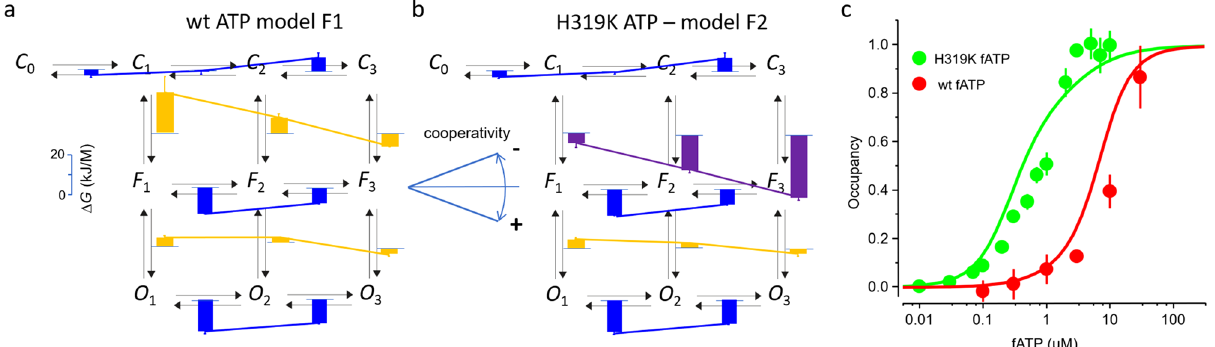
Figure 6. Gibbs free energies and predicted binding. ( a ) Gibbs free energy in model F1 and F2 for the association in the binding steps, Δ G A , at the ligand concentration L = 1 μM close to the EC 50 value of 1.2 μM (blue bars) and Δ G E for the closed-flipped and flipped-open isomerisations (ochre bars), according to model F1. The blue lines indicate negative cooperativity for the binding steps and the ochre lines positive cooperativity for both isomerisations. ( b ) Same as a but for H319K ATP and with model F2. Compared to wt, Δ G E for the closed- flipped isomerization in H319K is notably decreased at all degrees of liganding, thereby preserving the degree of cooperativity (purple bars and lines). ( c ) Comparison of experimental fATP binding to wt and H319K channels (data points, n = 3–6), obtained from a previous study 27 , superimposed by the binding computed by the 4 global fit (continuous